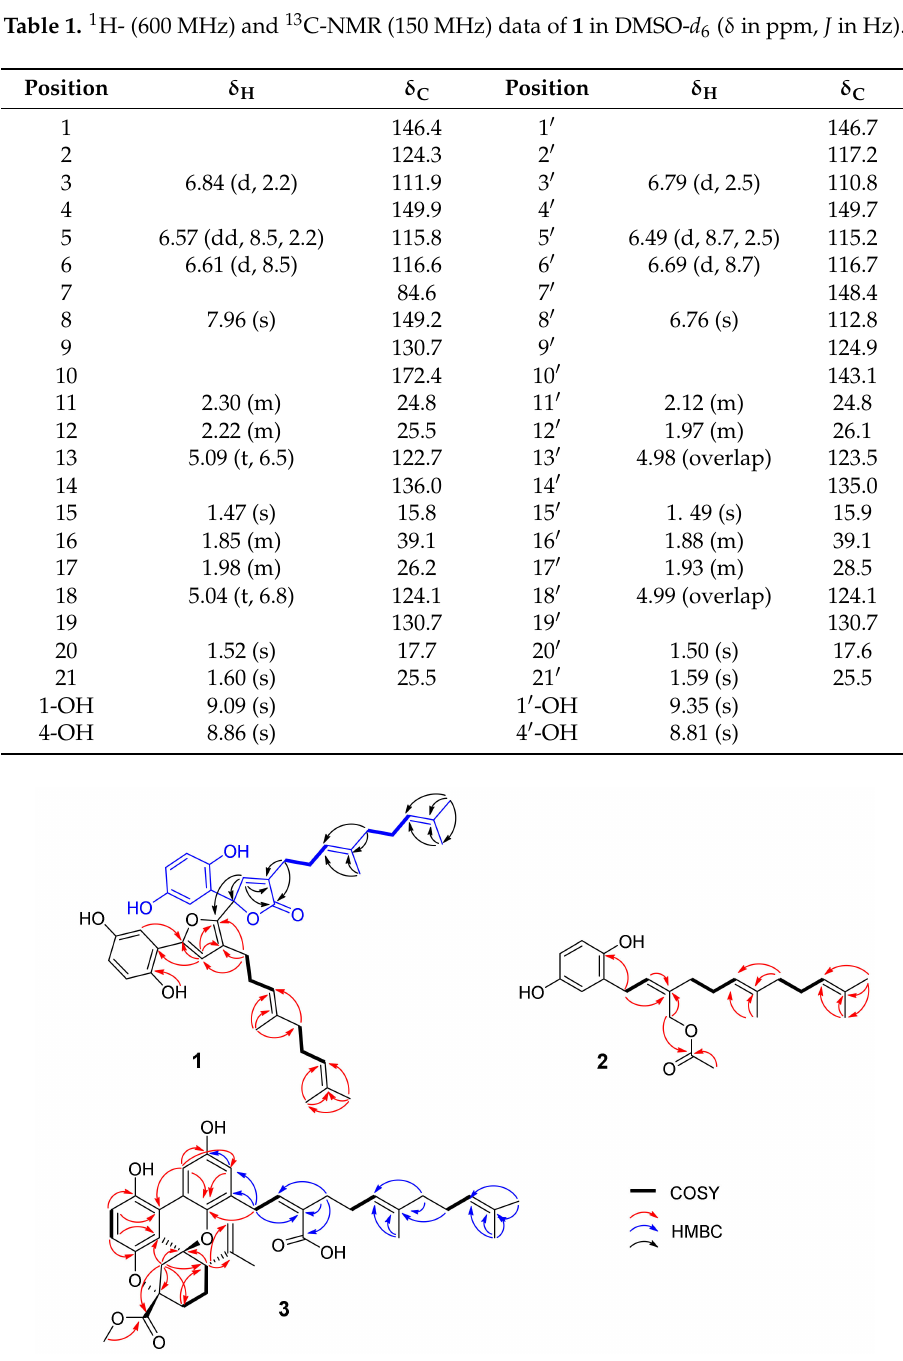
Figure 2. Key 1 H- 1 H COSY and HMBC correlations for ( 1 – 3